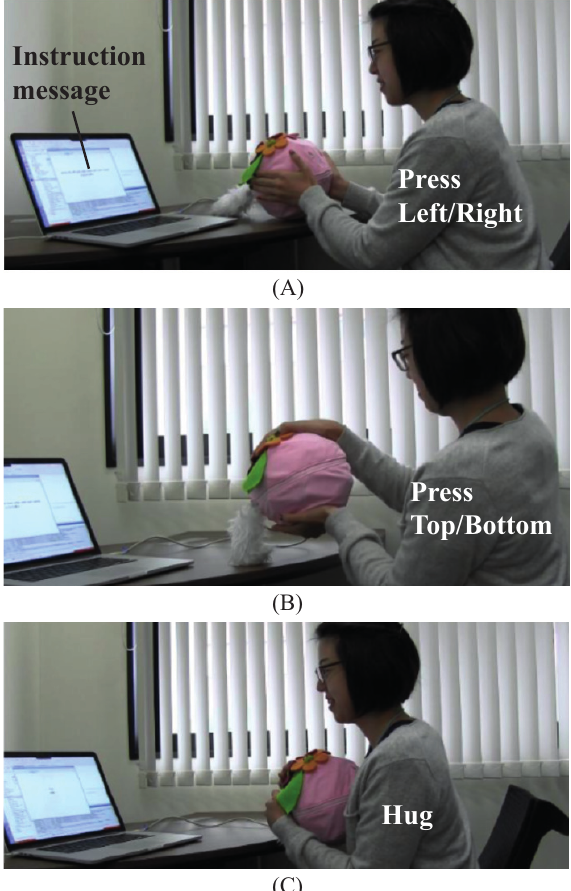
Figure 7. ( A ) participant during the “press left/right” instruction; ( B ) participant during the “press upper/lower” instruction and ( C ) participant during the “Hug”